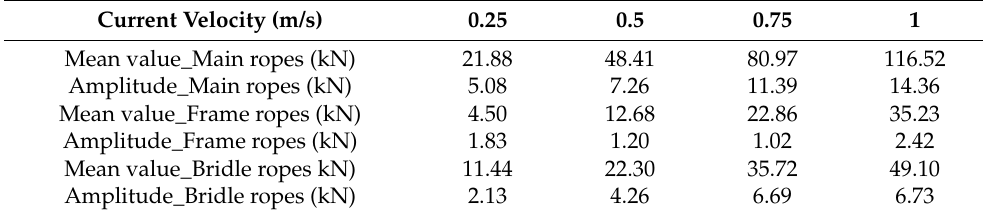
Table 3. The mean values and amplitudes of the maximum mooring forces in different parts of the mooring system under different current velocities.